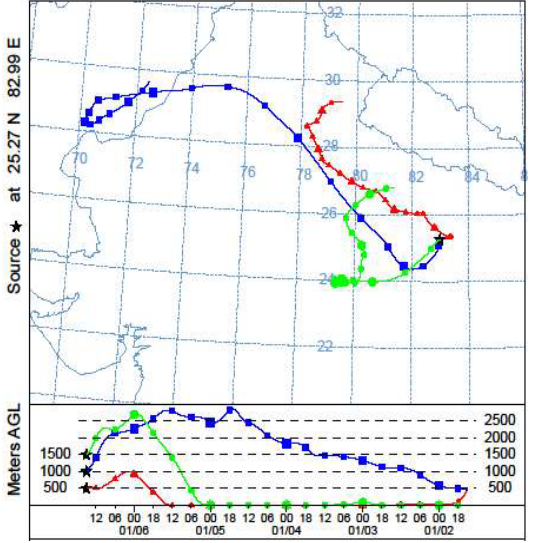
Figure 2: The Five days back trajectories using HYSPLIT model over Varanasi for 6 January